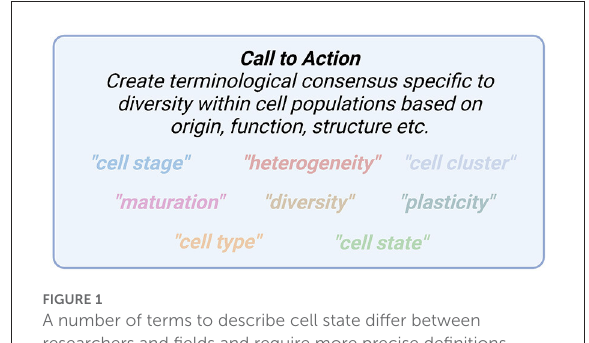
FIGURE1 A number of terms to describe cell state differ between researchers and fields and require more precise